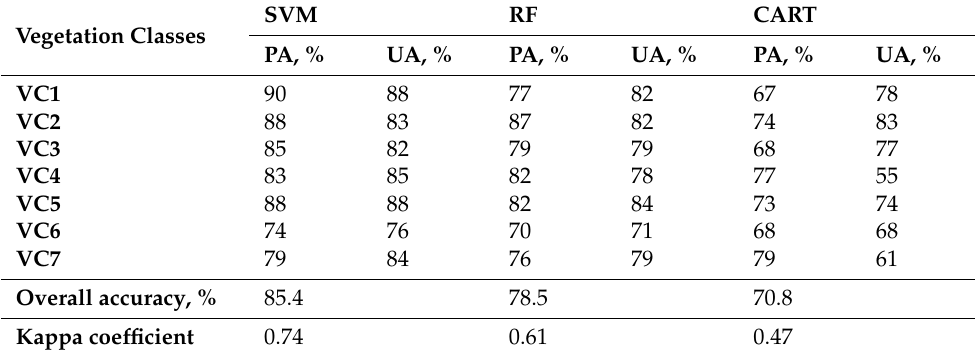
Table 4. Classification accuracy of three